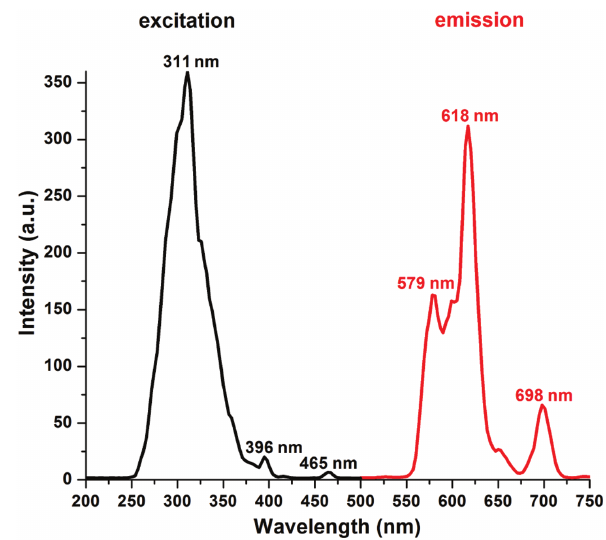
Figure 7: The PL spectra of Sr 3 SiO 5 : Eu 3+ , Dy 3+ system